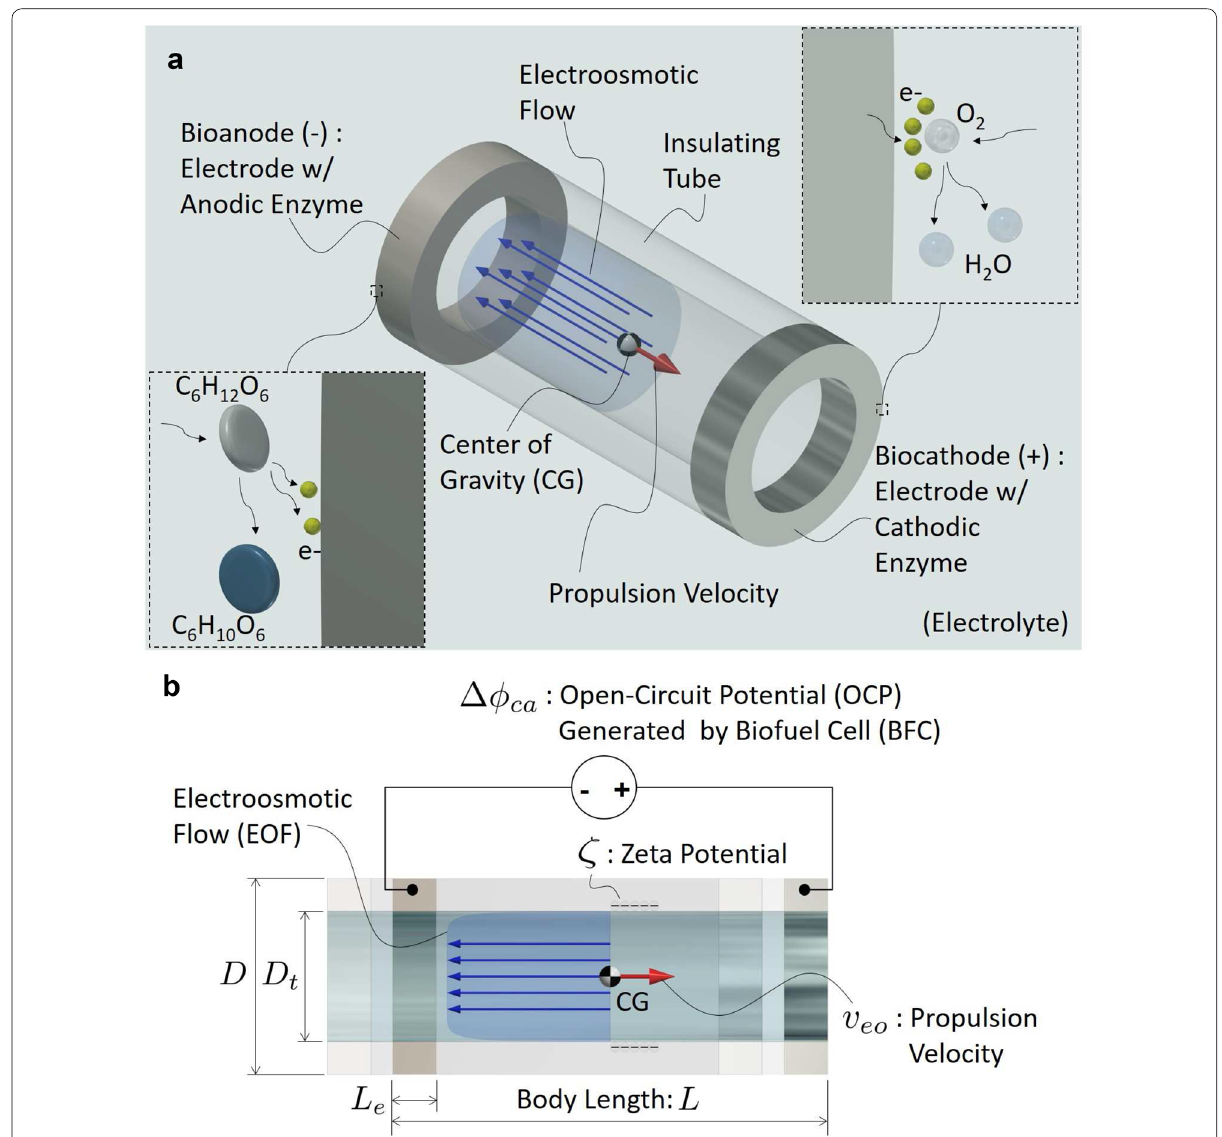
Fig. 1 Concept of microswimmer using BFC and EOP [11]. a Configuration and mechanisms. b Main